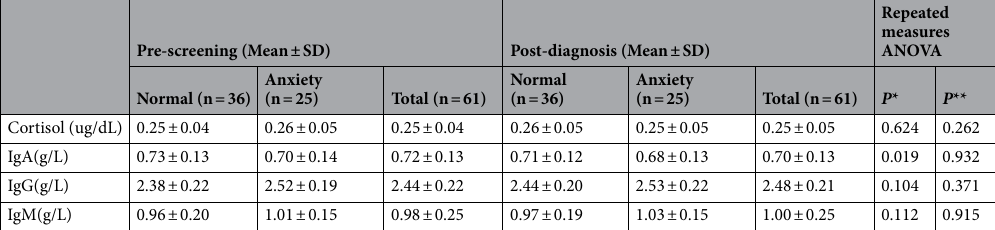
Table 3. Comparison of cortisol and immunoglobulin levels among participants at pre-screening and post- diagnosis: by anxiety disorders status. Data did not show normal distributions were transformed using Box- Cox-power transformation. All values of λ are considered the optimal value for data is selected; the “optimal value” is the one that results in the best approximation of a normal distribution curve. LGIN Low-grade intraepithelial neoplasia. *Main effect. **Interaction with pathology.